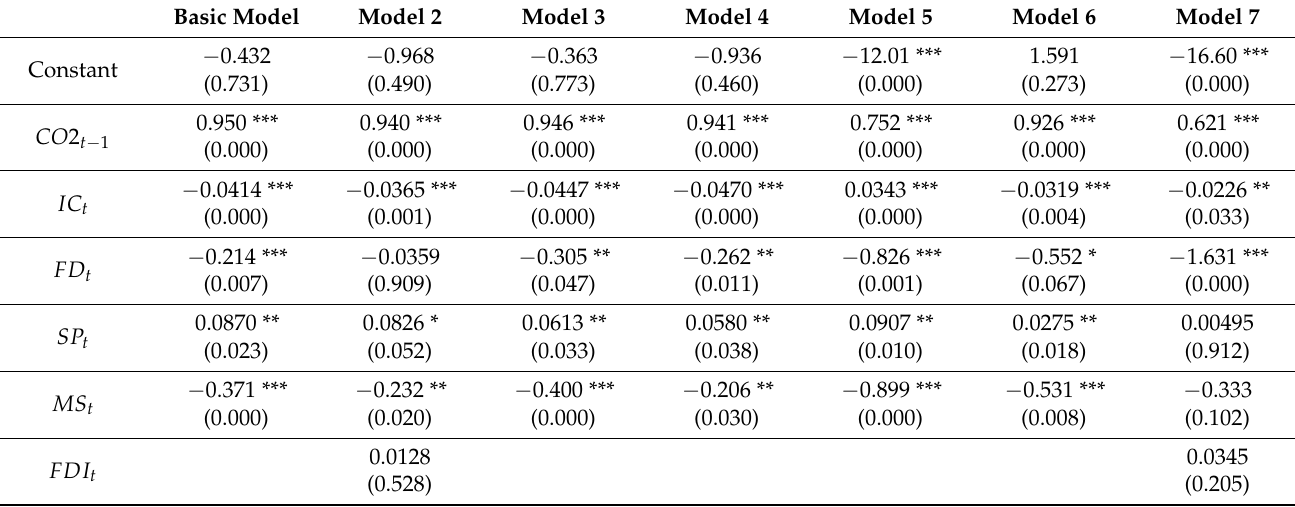
Table 3. Arellano-Bover/Blundell–Bond dynamic-panel-data estimations for 23 OECD countries, yearly data